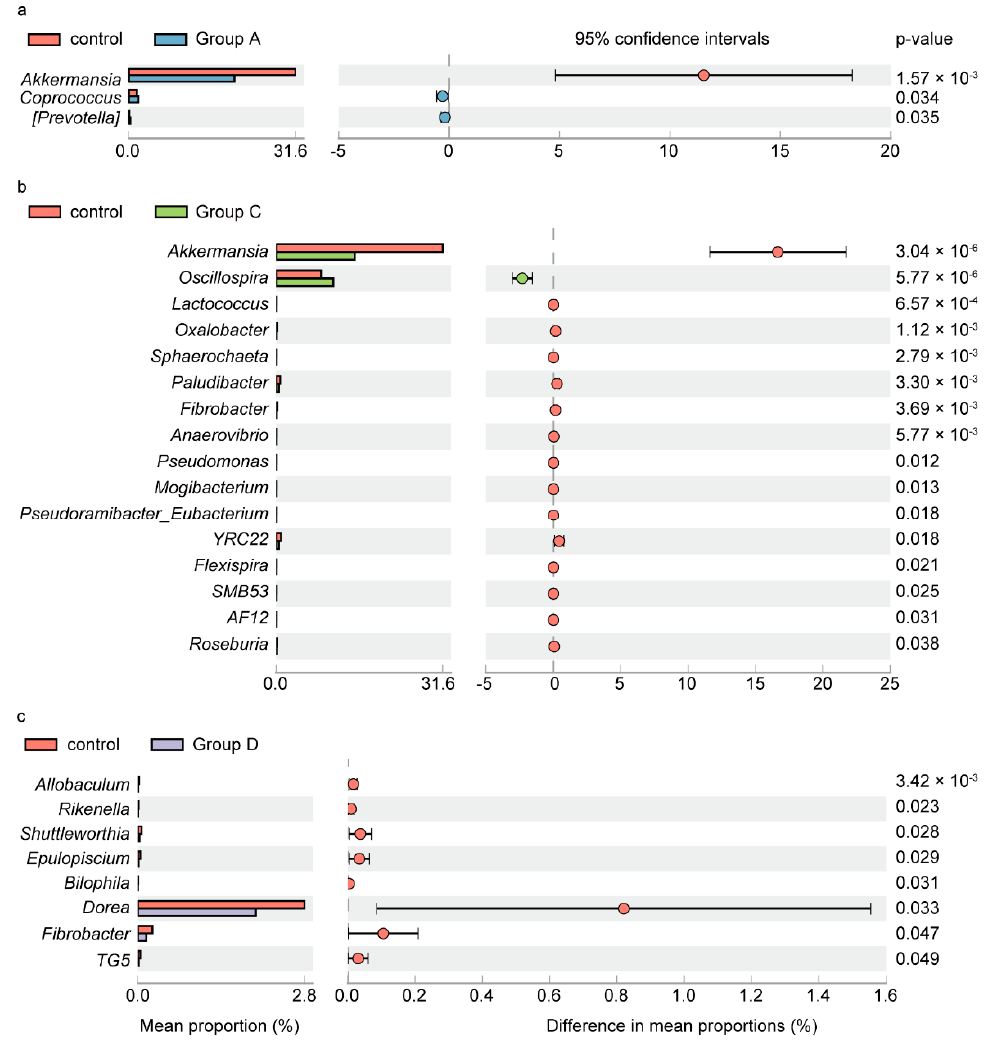
Figure 4. Relative abundance between control and groups A, C, and D with significant difference in bacterial genera. Extended error bar plots ( a – c ), display the differences in mean abundance of taxa in Groups A, C, and D compared to control ( p < 0.05, confidence intervals = 95%), respectively. Analysis is performed with STAMP2.1.3 and the p values are based on t-test. Prevotella with square brackets is proposed by the Greengenes curators and indicating the recommended